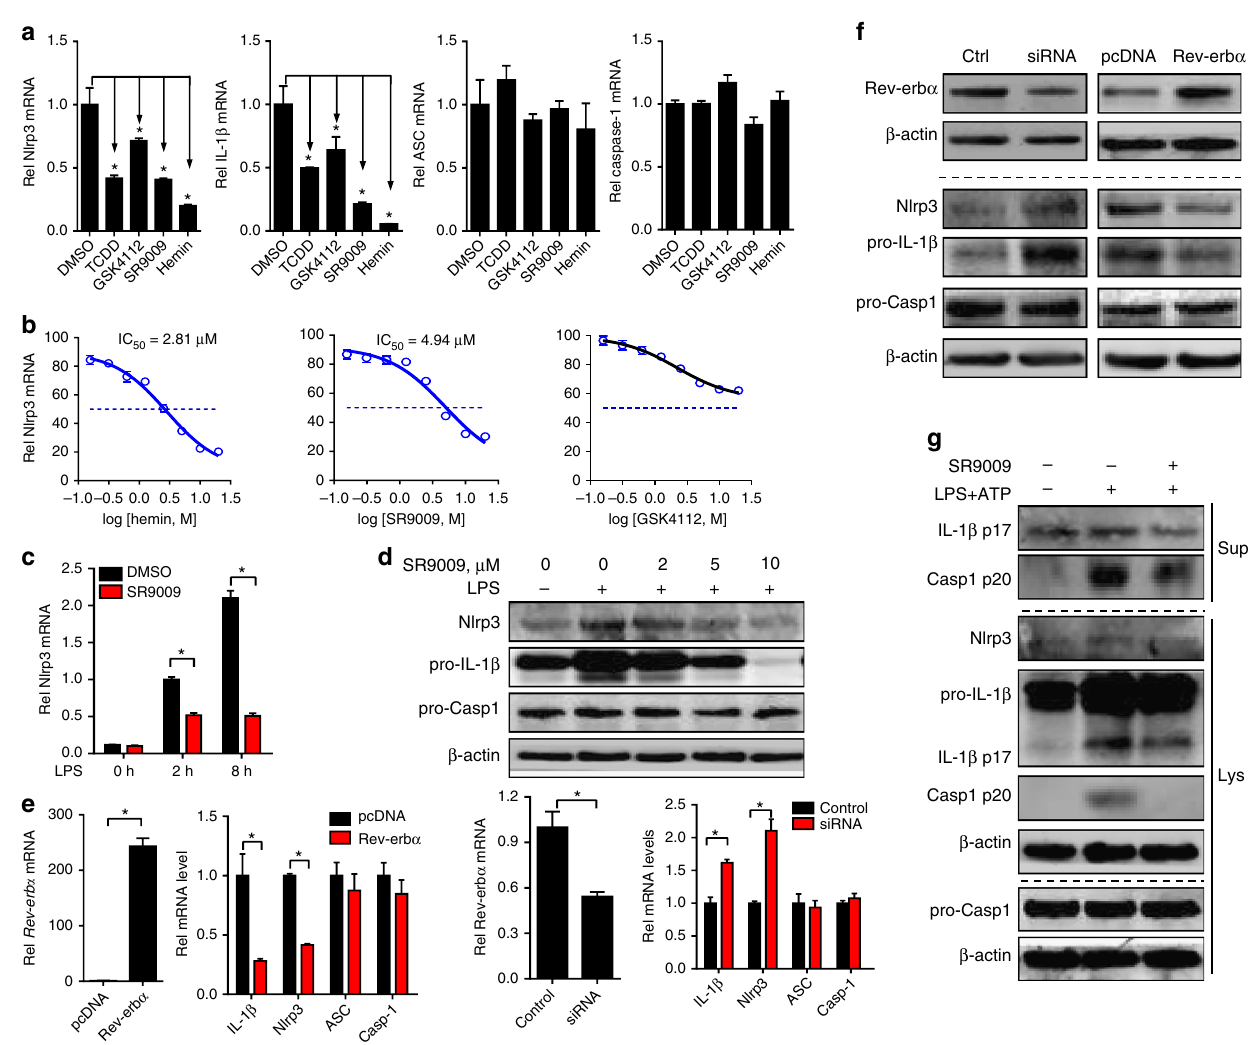
Fig. 4 Rev-erb α inactivates Nlrp3 in fl ammasome at the priming step. a qPCR measurements of Nlrp3 , IL-1 β , ASC , and caspase-1 in Raw264.7 cells. The cells were pretreated with Rev-erb α agonist (10 μ M), TCDD (10 nM, as a positive control), or vehicle for 1 h and then stimulated with LPS for 8 h. Data are mean ± SD ( n = 3). * P < 0.05 versus DMSO-treated group (Mann – Whitney U test). b Measurements of Nlrp3 mRNAs in Raw264.7 cells by qPCR. The cells were pretreated with DMSO or a series of concentrations of Rev-erb α agonist (SR9009, hemin, or GSK4112) for 1 h and then stimulated with LPS for 8 h. c Measurements of Nlrp3 mRNAs in Raw264.7 cells by qPCR. The cells were pretreated with DMSO or SR9009 (10 μ M) for 1 h and then stimulated with LPS for indicated hours. d Protein expressions of Nlrp3, pro-IL-1 β , ASC, and pro-caspase-1 in Raw264.7 cells measured by western blotting. The cells were pretreated with DMSO or SR9009 (10 μ M) for 1 h and then stimulated with LPS for 12 h. e mRNA expressions of Nlrp3 , IL-1 β , ASC , and caspase-1 in Raw264.7 cells measured by qPCR. The cells were transfected with Rev-erb α siRNA or Rev-erb α plasmid for 24 h and then stimulated with LPS for 8 h. f Protein expressions of Nlrp3, Pro-IL-1 β , ASC, and pro-caspase-1 in Raw264.7 cells measured by western blotting. The cells were transfected with Rev- erb α siRNA or Rev-erb α plasmid for 24 h and then stimulated with LPS for 12 h. g Western blotting of Nlrp3, cleaved caspase-1 (p20), cleaved IL-1 β (p17), pro-caspase-1, and pro-IL-1 β in the supernatants (Sup) or cell lysates (Lys) of PMs. PMs were pretreated with SR9009 or vehicle for 1 h and then stimulated with LPS for 12 h and ATP for 30 min (added last). The concentrations of LPS and ATP for cell treatment were 100 ng/ml and 2 mM, respectively. Each western blot is representative of three independent experiments (statistical differences between blot density levels were analyzed by Mann – Whitney U test, Supplementary Figure 12). In panels c and e , data are mean ± SD ( n = 3), * P < 0.05 (Mann – Whitney U test). Casp1: